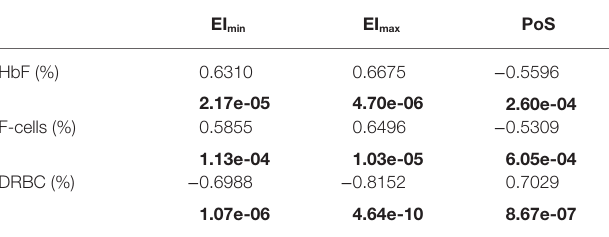
TABLE 2 | Correlations of oxygenscan parameters with fetal hemoglobin, F-cells, and dense red blood cells. EI min EI max